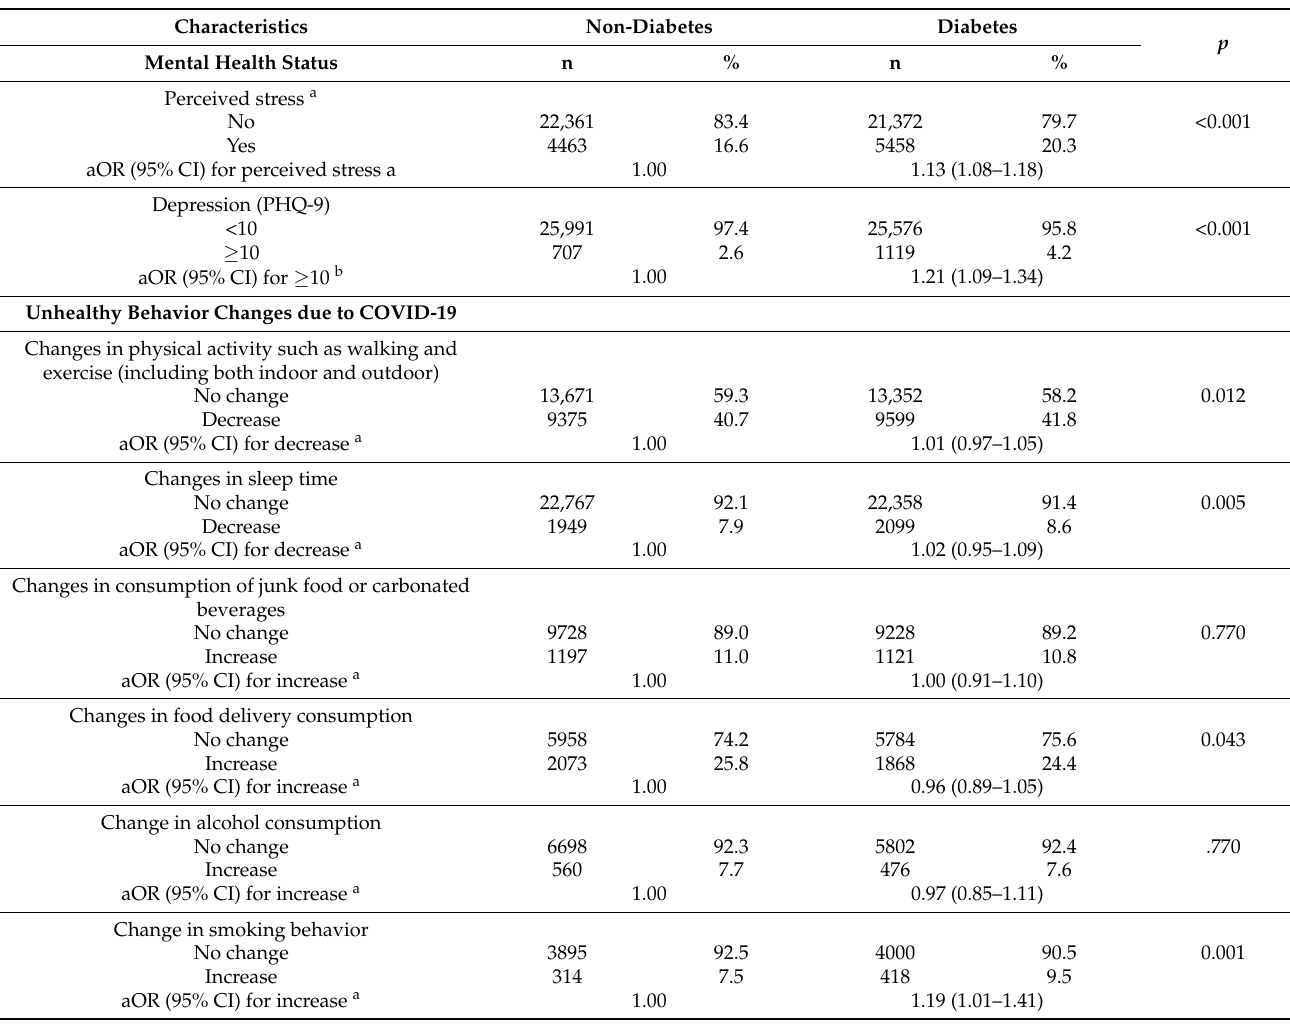
Table 2. Mental health status and unhealthy behavior changes due to COVID-19 among diabetes compared to